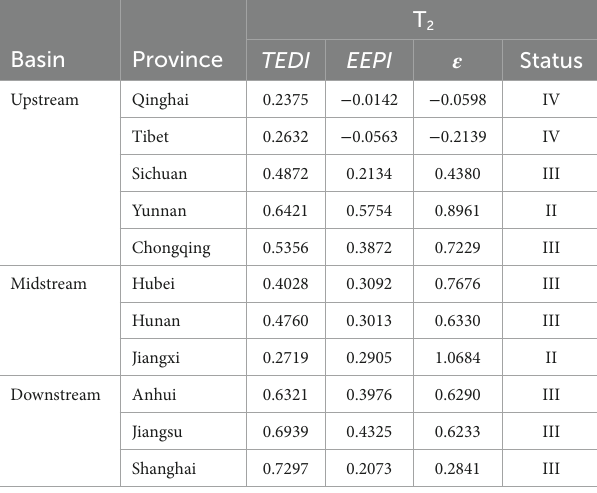
TABLE 4 Dynamic decoupling analysis of tourism economic development and ecological environment pressure in the Yangtze River basin from 2010 to 2019.